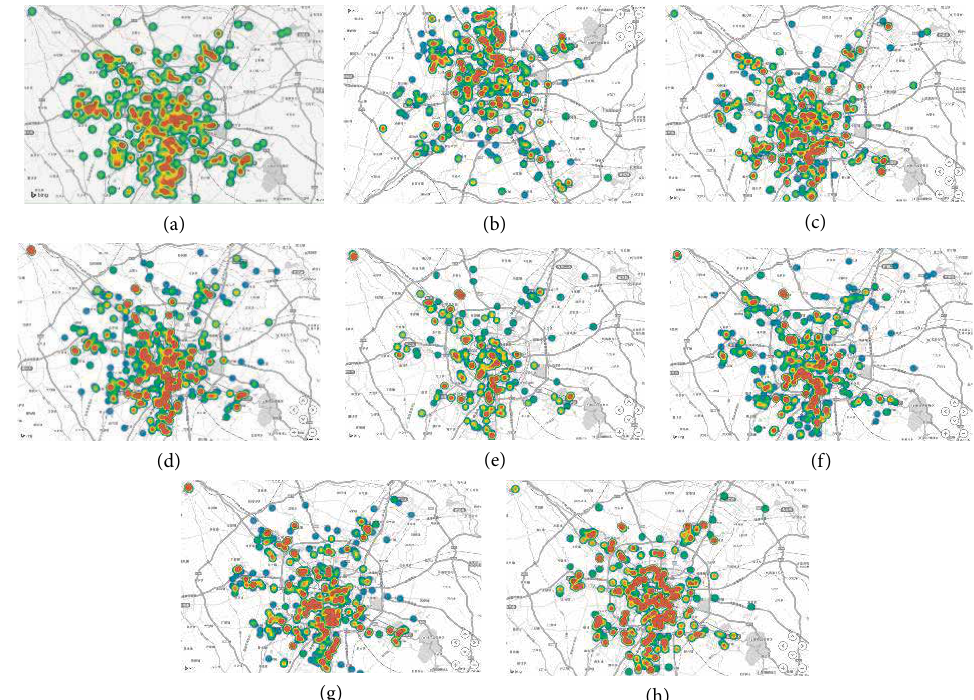
Figure 11: Real demand distribution on the map during different time periods. (a) 00:00–07:00. (b) 07:00–09:00. (c) 09:00–12:00. (d)